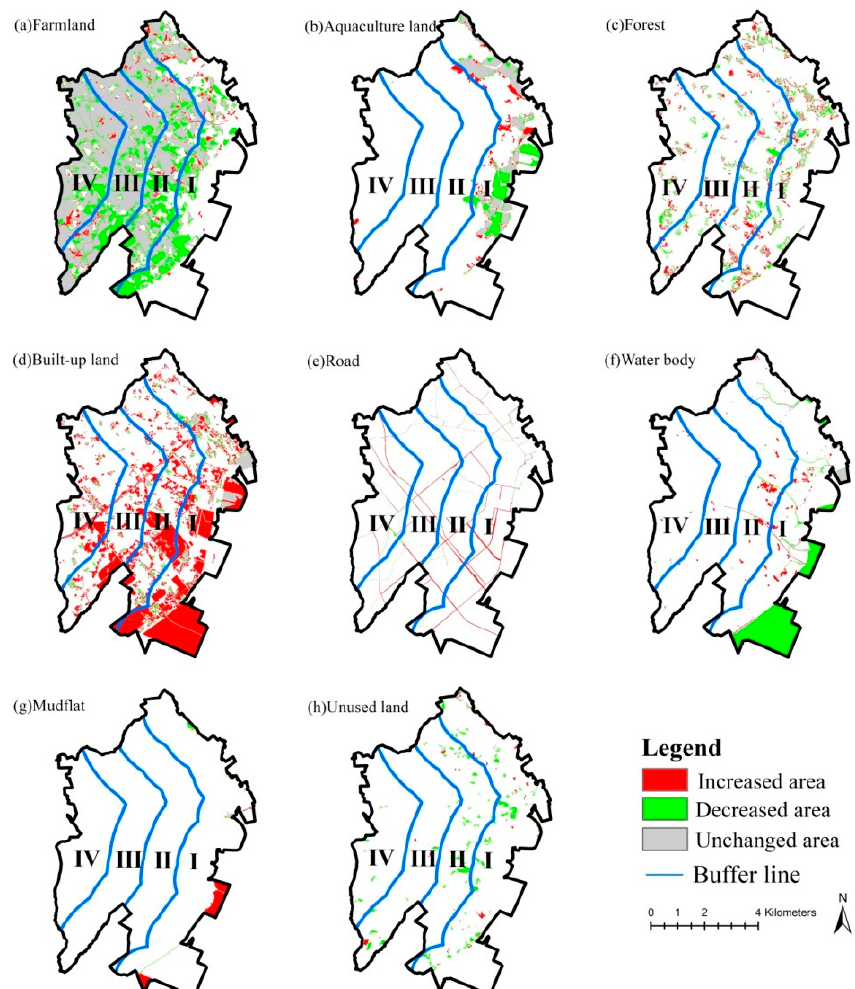
Figure 11. Spatial pattern of landscape type variations in the study area from 2005 to 2020. (Gradient I (0–2 km), gradient II (2–4 km), gradient III (4–6 km) and gradient IV (>6 km) from the coastline to the inland).